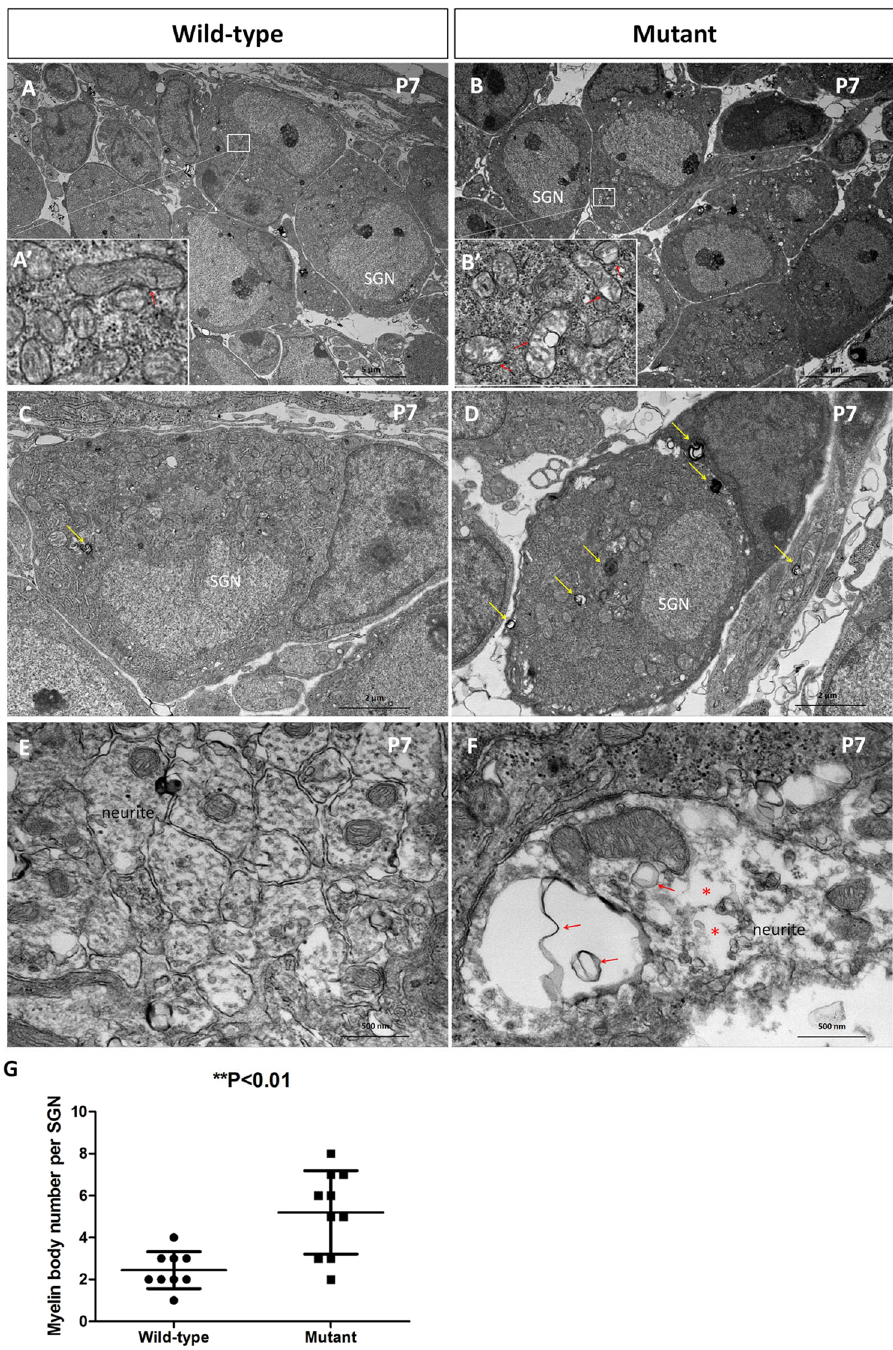
Figure 4. Spag6 mutant SGNs showed defects in SGN ultrastructures at P7 Transmission electron microscopy (TEM) ultrastructure of P7 SGNs. ( A,B ) are lower magnification pictures of wild-type ( A ) and mutant ( B ) SGNs. A’ and B’ are magnified zones in ( A,B ) panels, respectively. Compared with the wild-type cells (A’), the cristae of mitochondria were sparse (red arrows in B’). There were many more myelin bodies in the mutant SGN soma (yellow arrows in D ), whereas myelin bodies were only occasionlly seen in the wild-type SGN soma (yellow arrow in C ). Furthermore, the mutant SGN neurites had relatively sparse microtubules and actin filaments (asterisks in F ), as well as abnormal membranous structures (red arrows in F ). The wild-type cells had a dense arrangement of microtubules and actin filaments in cross sections ( E ). No abnormal membranous structures were observed in the wild-type neurites. ( G ) The graph showed the difference between the wild- type and mutant in myelin body number, which was statistically significantly (wild-type, 2.444 ± 0.8819, n = 9; muant, 5.200 ± 1.9890, n = 10; ** P < 0.01). “n” indicates the SGN